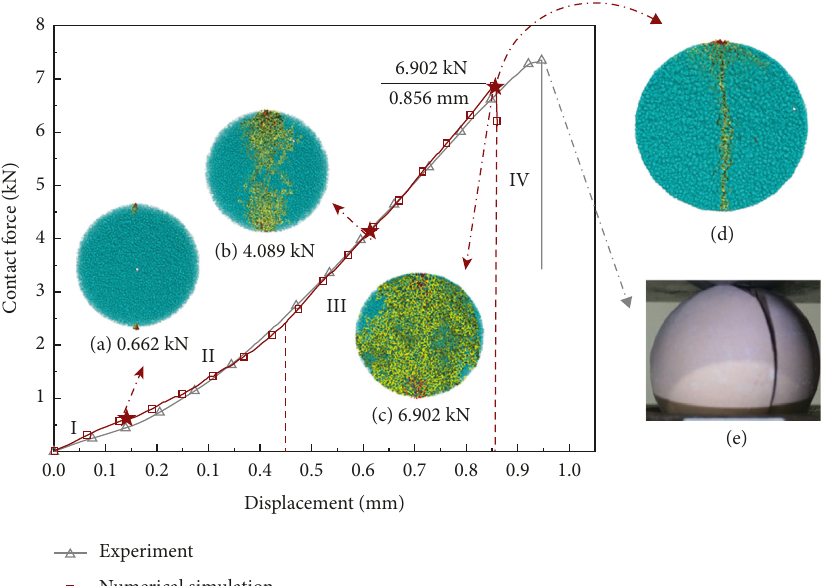
Figure 8: Force-displacement curve and breakage state of the samples: (a) 0.662kN (central vertical section), (b) 4.089kN (central vertical section), (c) breaking moment (central vertical section), (d) breakage state of numerical sample, and (e) breakage state of experiment [49].